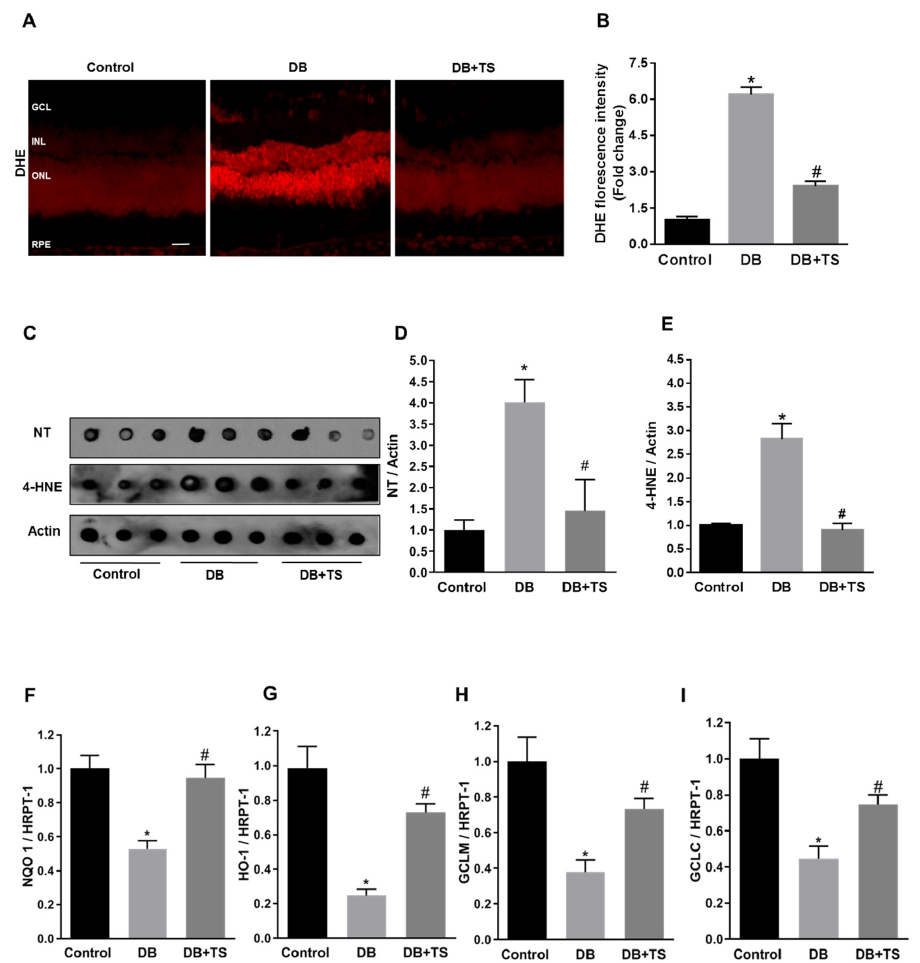
Figure 5. Effects of Tubastatin A on retinal redox homeostasis. ( A ) Representative images of retinal cryosections from the different experimental groups (control, DB and DB + TS) probed with dihydroethidium (DHE) to detect superoxide. Scale bar, 50 µ m. ( B ) Quantification of relative fluorescence intensity of DHE staining. Values are mean ± SEM for n = 6. Results are presented as a fold change of control. * p < 0.01 vs. control and # p < 0.01 vs. DB. ( C ) Dot blot analysis assessing levels of nitrotyrosine (NT) and 4-hydroxynonenal (4-HNE) in retinas of three experimental groups (control, DB and DB + TS rats). ( D , E ) Quantification of optical density of NT and 4-HNE immunoblotting normalized versus actin. Values are mean ± SEM for n = 6. * p < 0.05 vs. control and # p < 0.05 vs. DB for NT. * p < 0.01 vs. control and # p < 0.01 vs. DB for 4 ‐ HNE. ( F – I ) mRNA levels of heme oxygenase ‐ 1 (HO ‐ 1), NAD( p )H dehydrogenase quinone 1 (NQO1), glutamate ‐ cysteine ligase regulatory subunit (GCLM) and glutamate ‐ cysteine ligase (GCLC) evaluated by qPCR and normalized to mRNA for hypoxanthine phosphoribosyltransferase 1 (HPRT ‐ 1). Values are mean ± SEM for n = 6. * p < 0.05 vs. control and # p < 0.05 vs. DB. reduced endogenous antioxidant activities. Nuclear factor erythroid ‐ 2 ‐ related factor 2 (Nrf2) is a master regulator of endogenous antioxidants gene expression [22], therefore, we tested the effect of